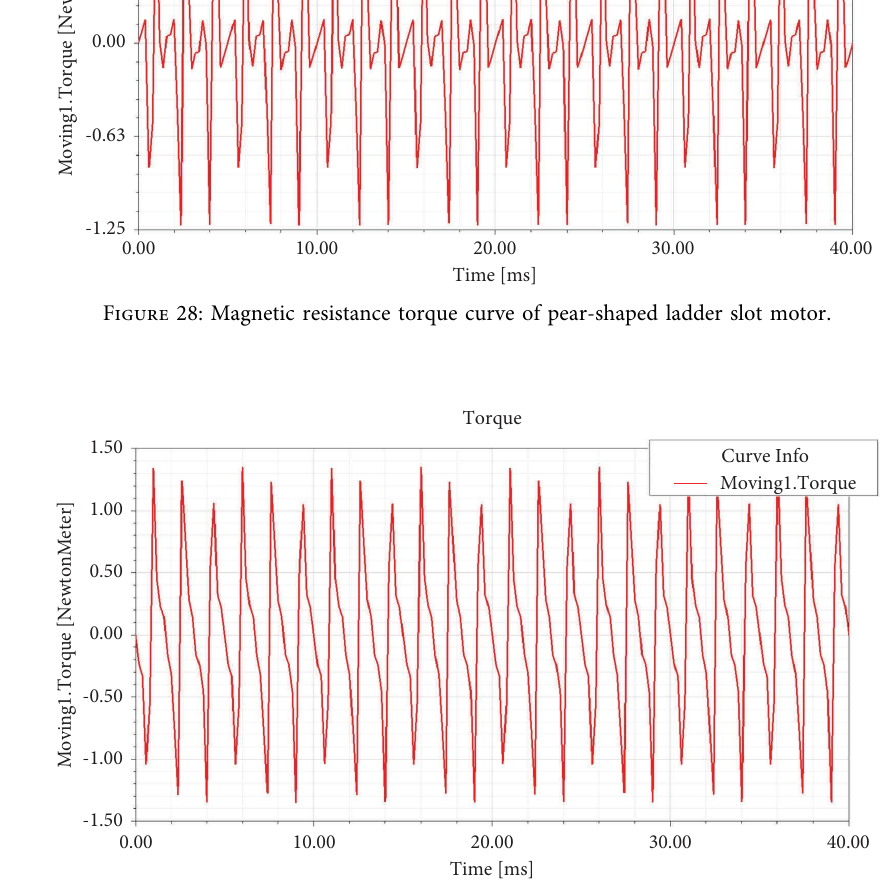
Figure 29: Magnetic resistance torque curve of pear-shaped circular slot